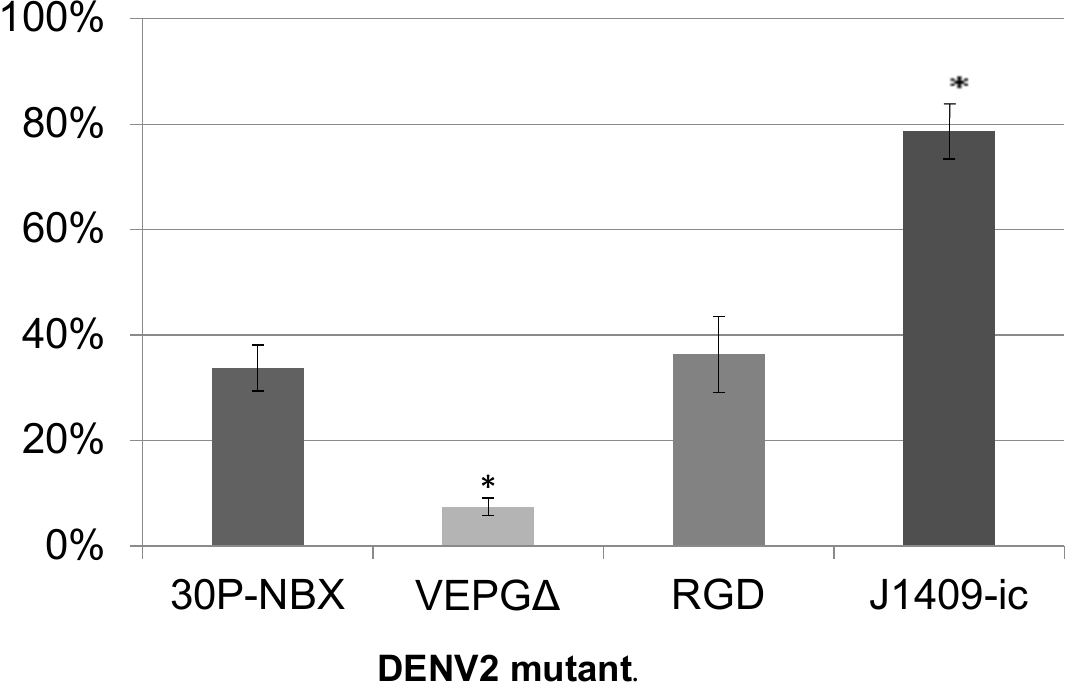
Figure 1. DENV2 MIRs in Ae. aegypti RexD mosquito midguts. RexD mosquitoes were orally challenged with each virus, maintained for seven days until midguts were dissected, and MIRs were determined by IFA. Data are the average of at least three experiments and significance was determined by comparison with 30P-NBX via student’s t test (* p -value < 0.05).